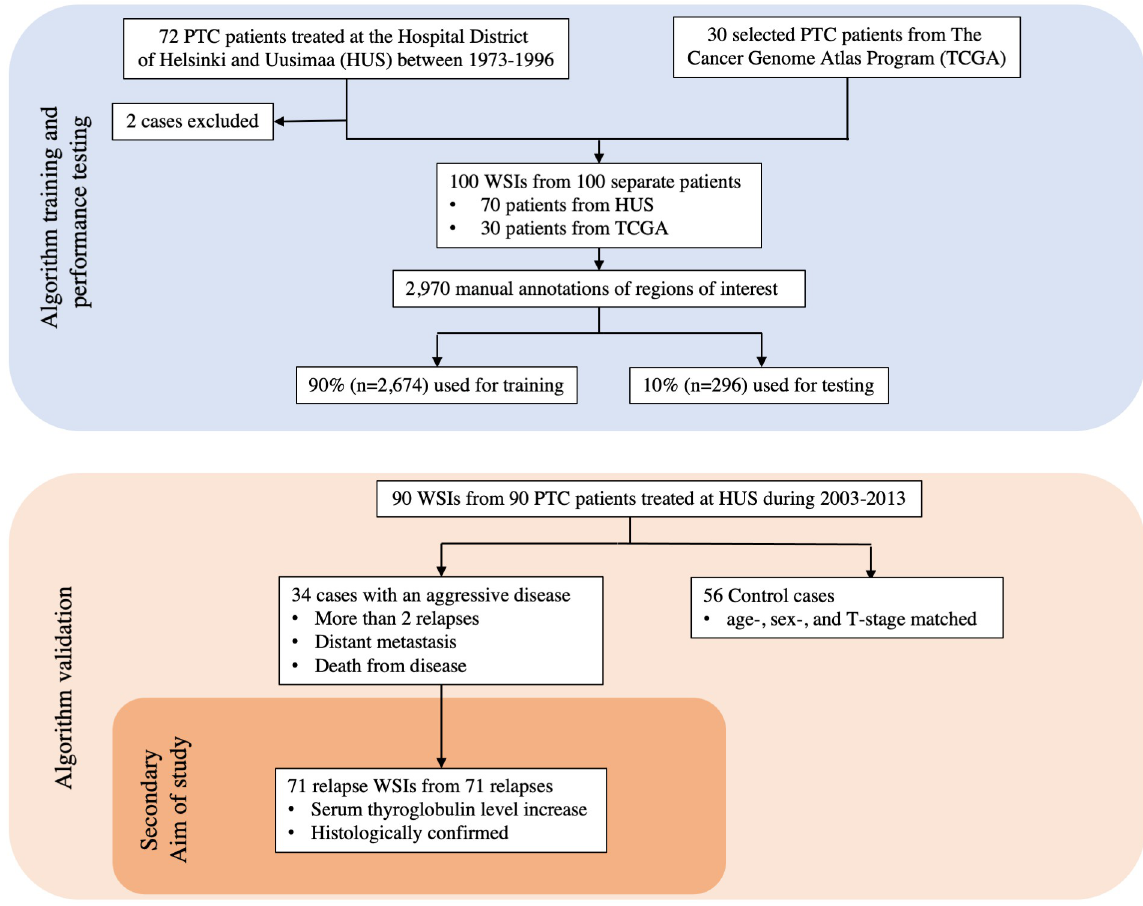
Fig 1. CONSORT flow diagram of the datasets used in the study. Papillary thyroid carcinoma is abbreviated as PTC.